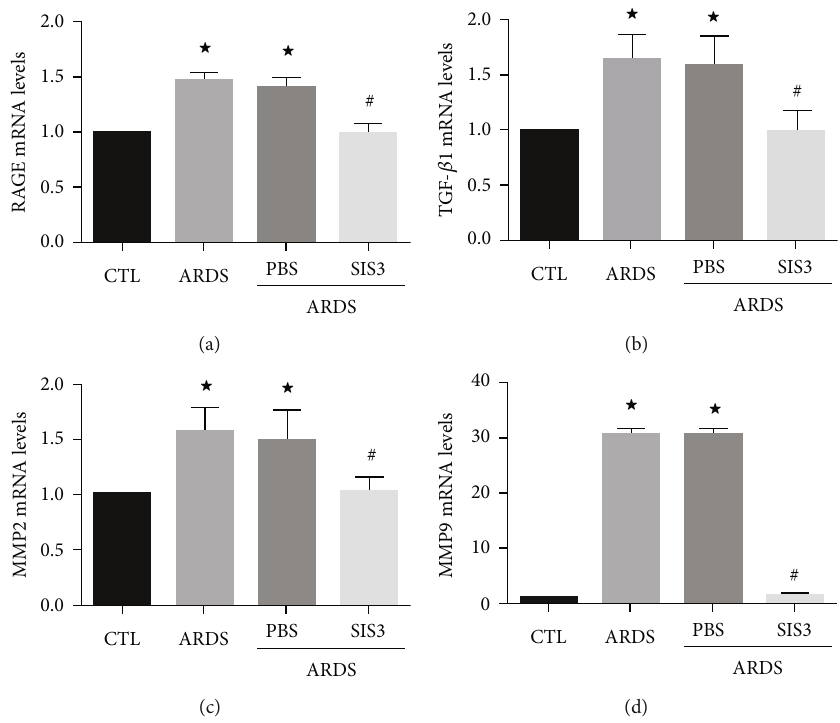
Figure 1: SIS3 inhibits mRNA expression of RAGE, TGF- β 1, MMP2, and MMP9 in lung homogenates of ARDS rats. The mRNA levels of RAGE, TGF- β 1, MMP2, and MMP9 were determined using real-time PCR and were standardized to β -actin. The results suggested that SIS3 inhibited the increase of (a) RAGE, (b) TGF- β 1, (c) MMP2, and (d) MMP9 in LPS-induced lung homogenates of ARDS rats, while no e ff ect was seen upon pretreatment with PBS. The data are presented as the means ± SD ( n = 10 ). ★ P < 0 : 05 vs. CTL; # P < 0 : 05 vs.